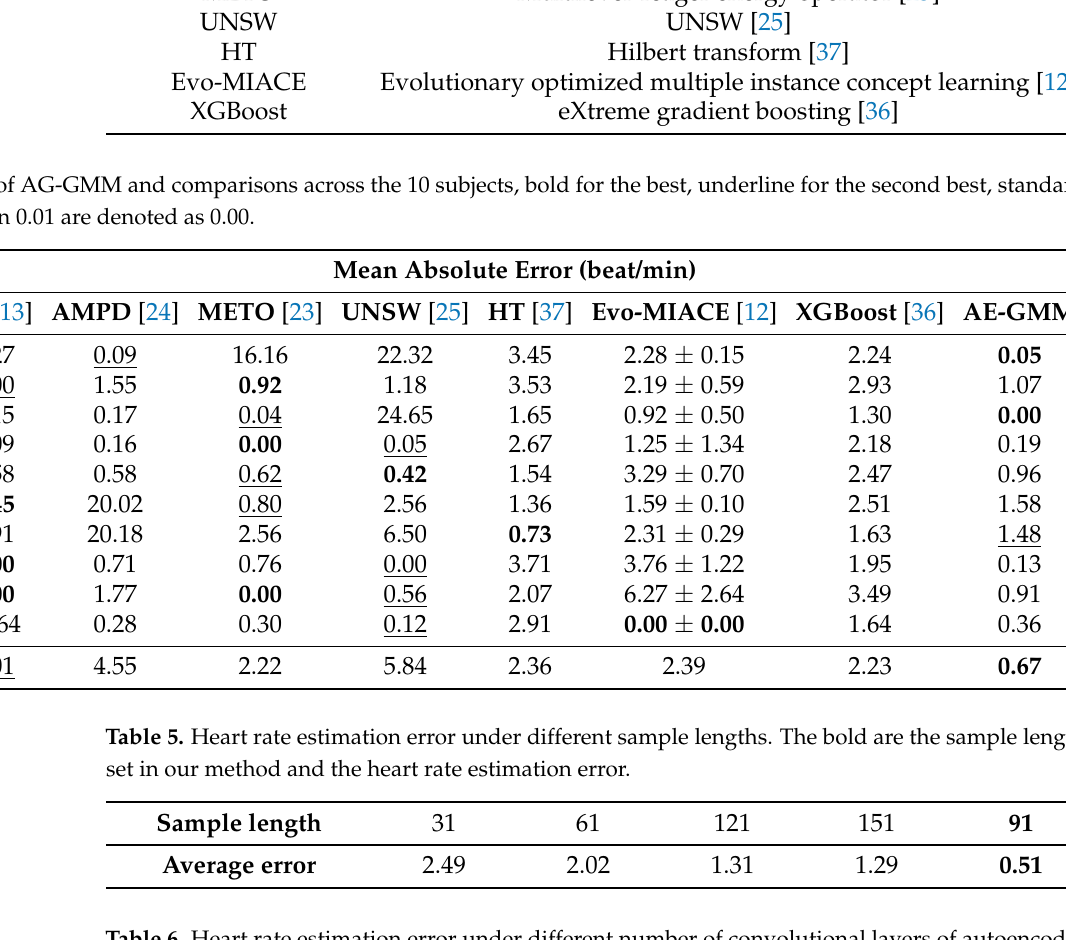
Table 6. Heart rate estimation error under different number of convolutional layers of autoencoder. The bold are the number of layers set in our method and the heart rate estimation